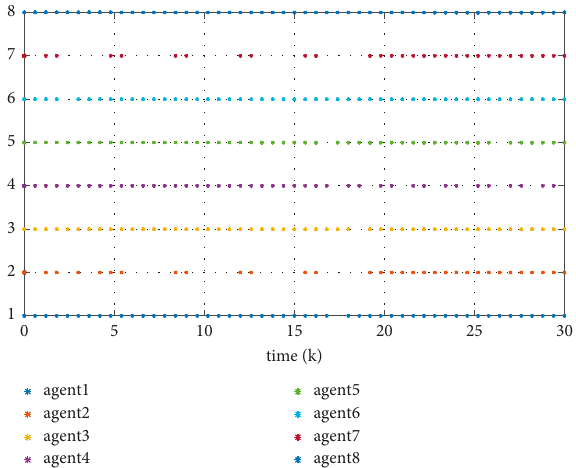
Figure 5: Event-triggered instants of the